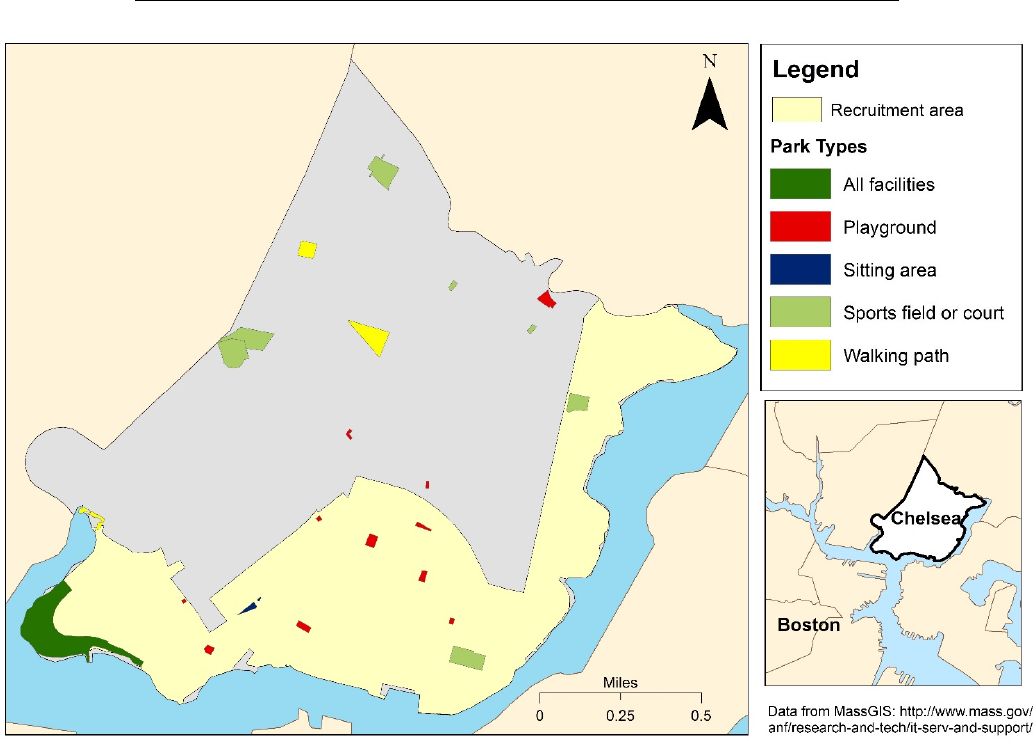
Figure 1. Locations and types of parks in Chelsea, MA.